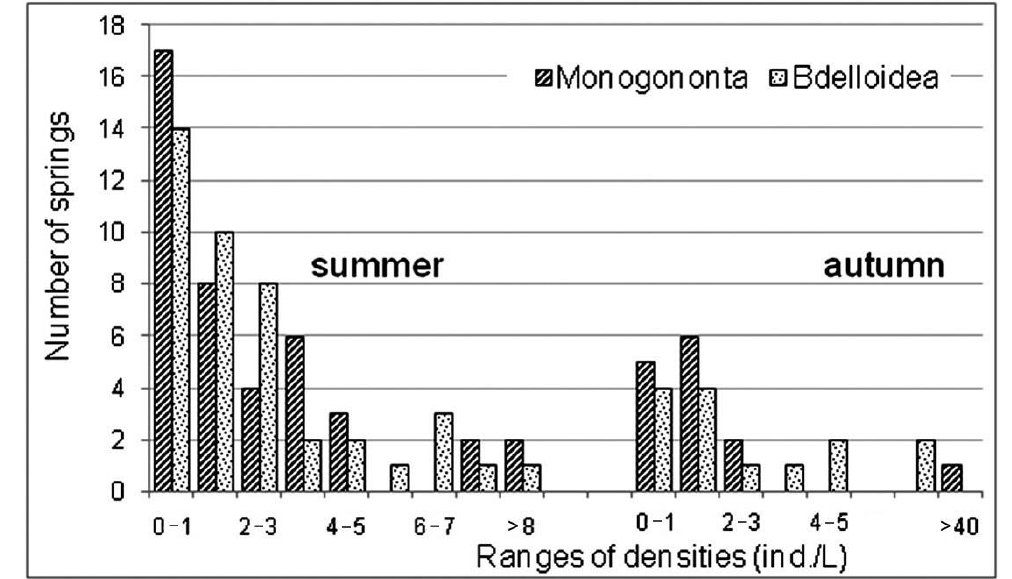
Figure 2. Range of rotifer densities in particular springs in the Knyszyn Forest.